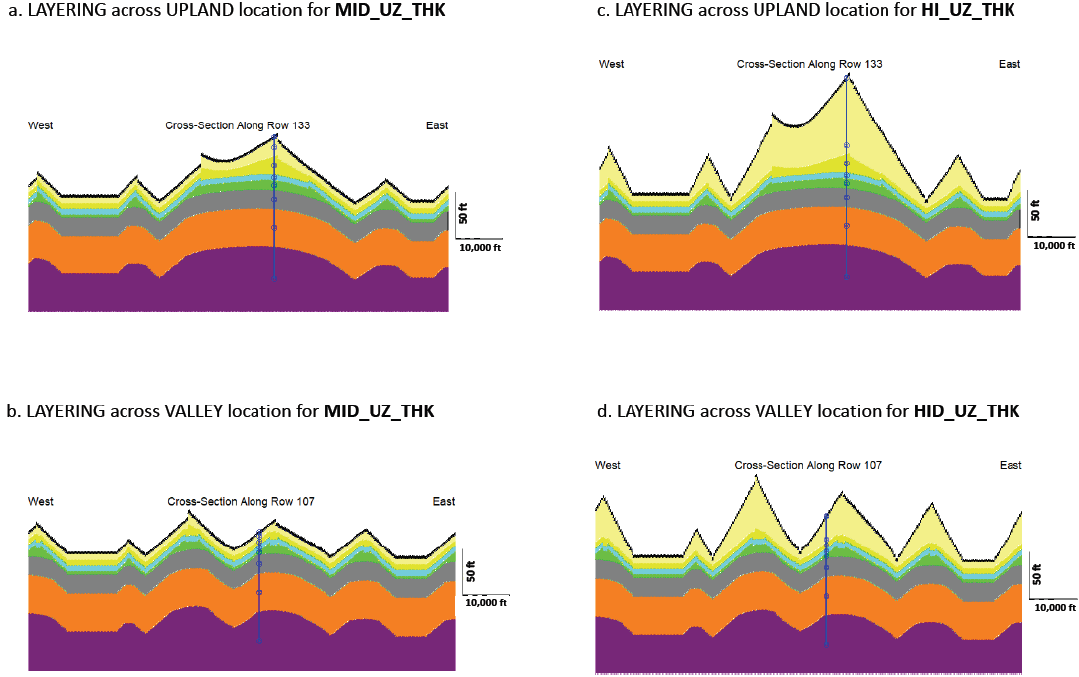
Figure 4. Layering through Upland and Valley locations; ( a ) MID_TRENDED model version, Upland cross section. ( b ) MID_TRENDED model version, Valley cross section. ( c ) HI_TRENDED model version, Upland cross section. ( d ) HI_TRENDED model version, Valley cross section. Cross section locations are shown in Figure 3. Top black layer is 3-ft thick receptor layer for receiving